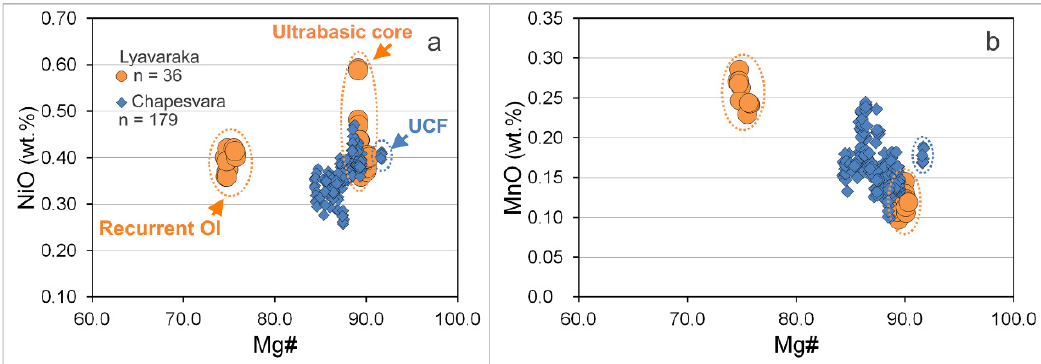
Figure 9. ( a , b ). Plot of values of the Mg# index, i.e., 100 Mg/ (Mg + Fe 2+ + Mn) in olivine versus contents of NiO ( a ) and MnO ( b ), both expressed in weight %, in WDS compositions of grains from the Lyavaraka complex (orange symbol; this study) compared with olivine from the Chapesvara complex, Serpentinite Belt (blue symbol), after [12]. The number of WDS data-points (n) is reported in ( a ). The label UCF refers to the Upper Contact Facies [12].